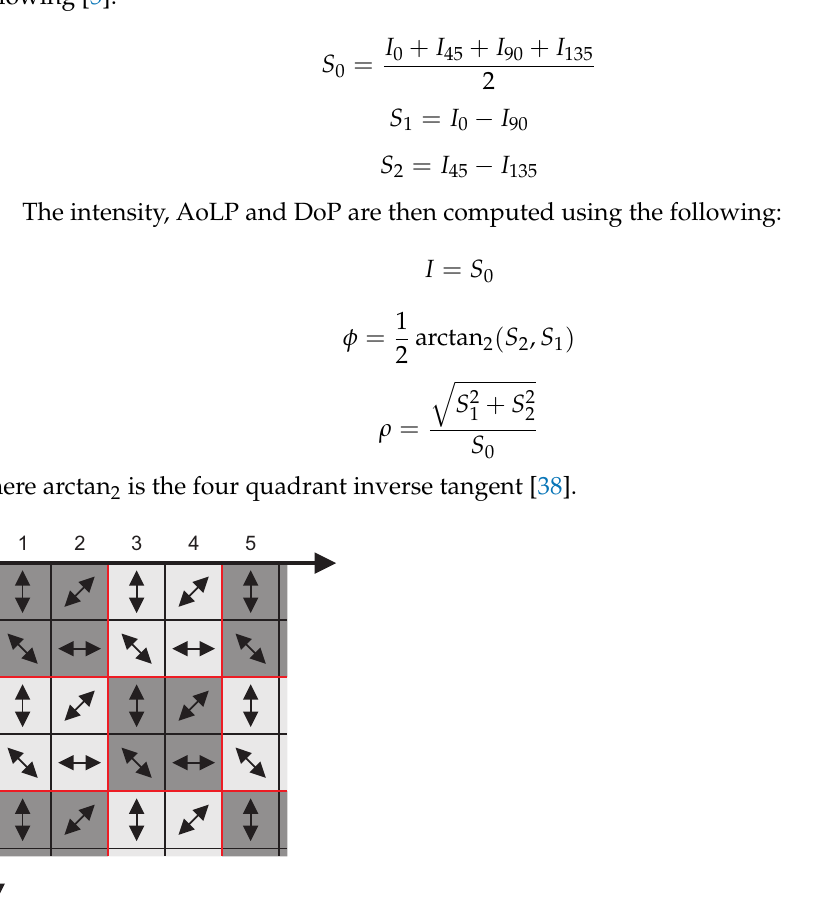
Figure 1. Pixel micro-filter pattern on the Sony XCG-CP510 sensor chip. The arrows indicate the transmission axes of the filter on each sensor